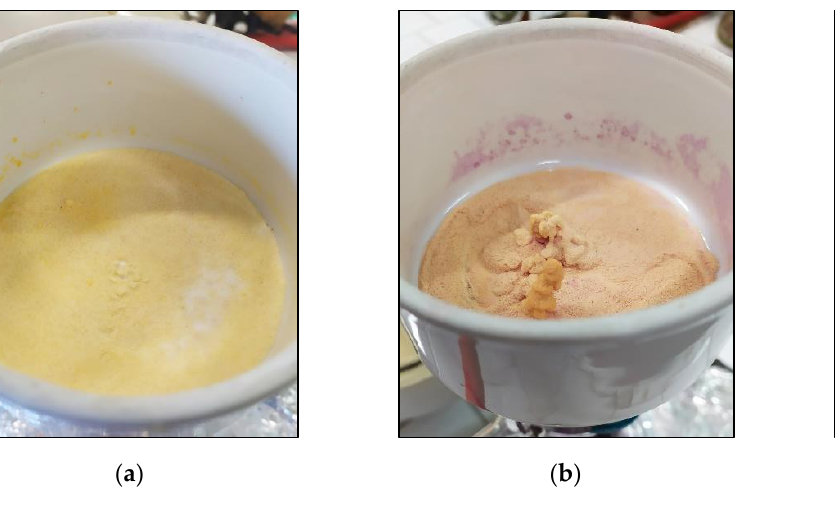
Figure 1. Reaction scheme for covalent anchoring of o -cresol red to CMC.